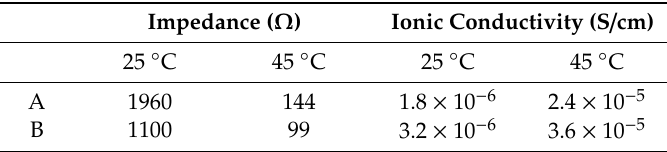
Table 1. Impedance and ionic conductivity of the